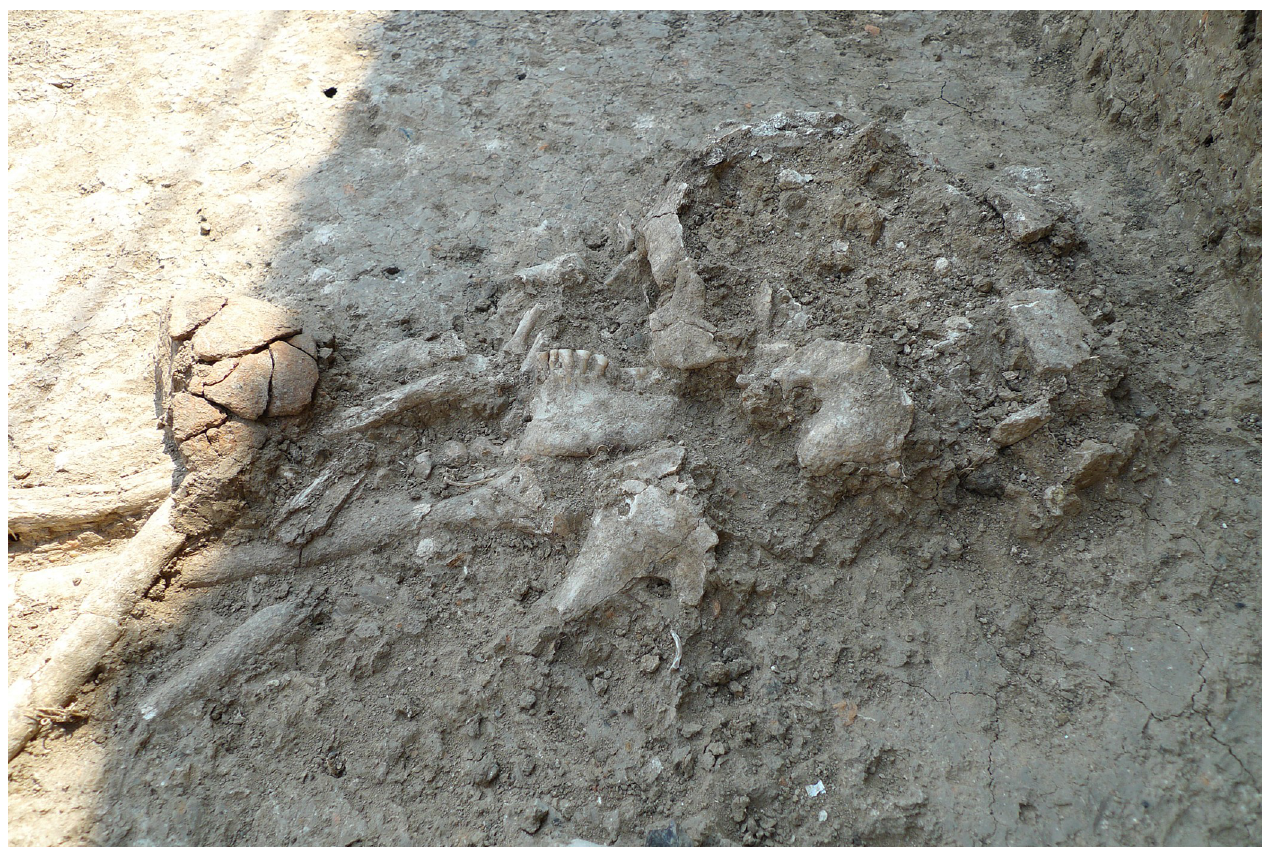
Fig 9. Position of the crucible in the grave R119 (Photo S.